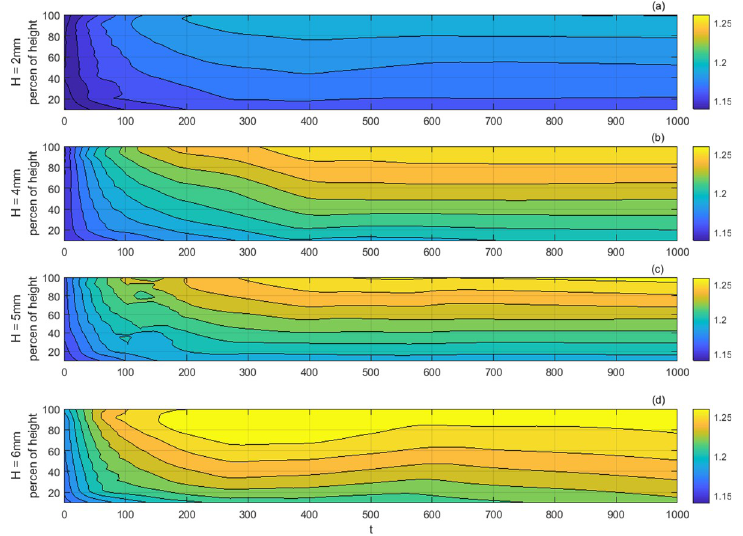
Fig 9. The contour plots of the accumulative packing density at various drop height. H : H = 2 mm (a), H = 4 mm (b), H = 5 mm (c) and H = 6 mm (d). Each panel here was obtained by the method of locally weighted linear regression, based on an average of 3 groups of separate measurements for the local packing